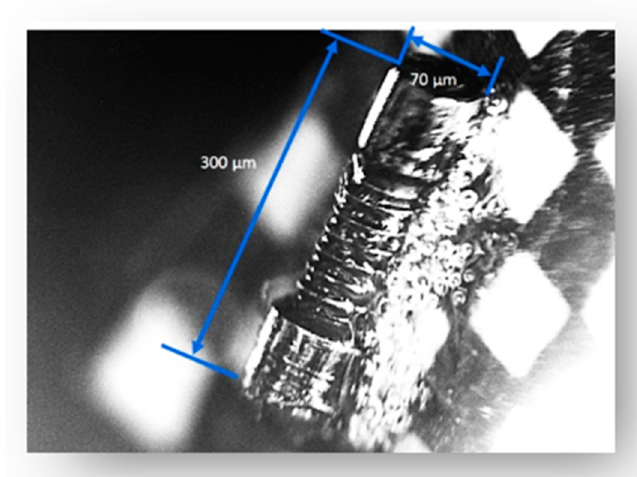
Figure 6. Object for experiments.